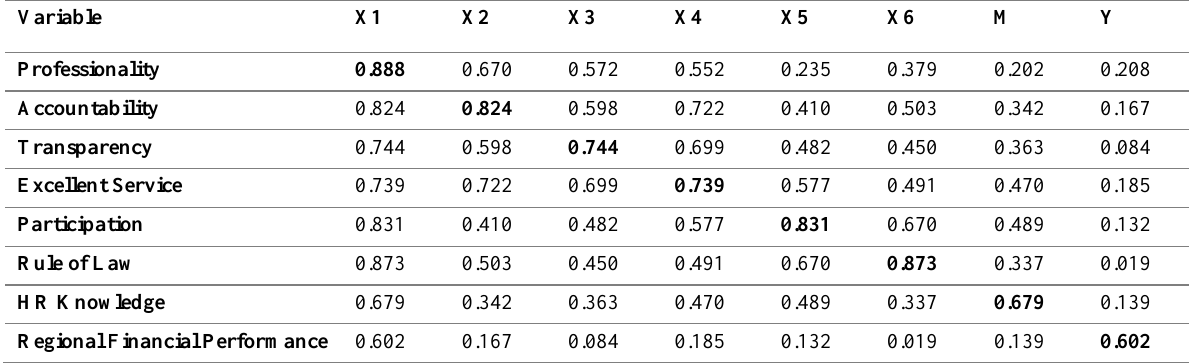
Table 4: Discriminant Validity Test (Root of